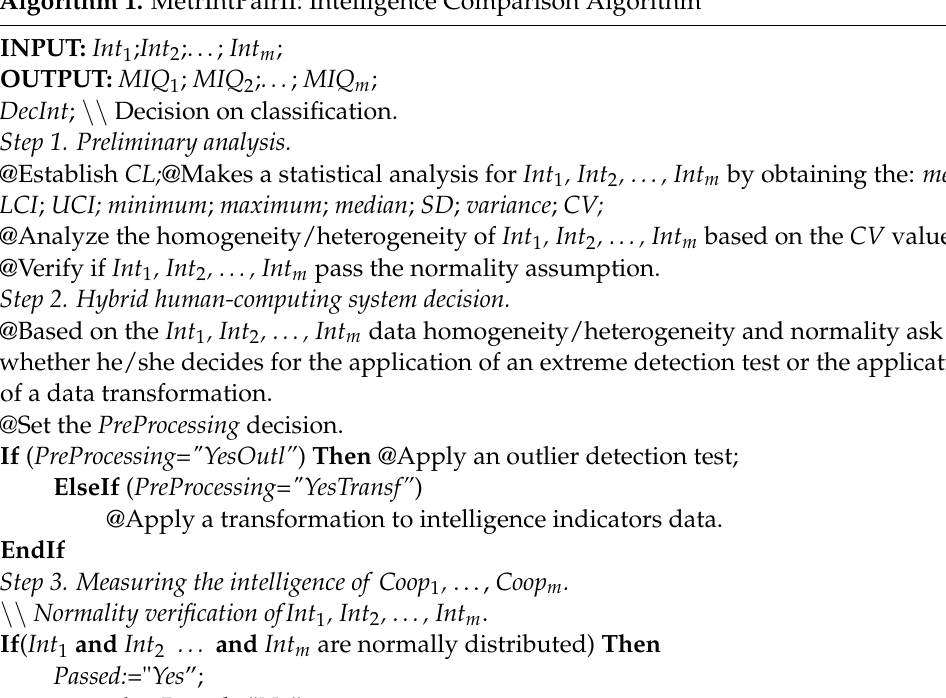
Algorithm 1. MetrIntPairII: Intelligence Comparison